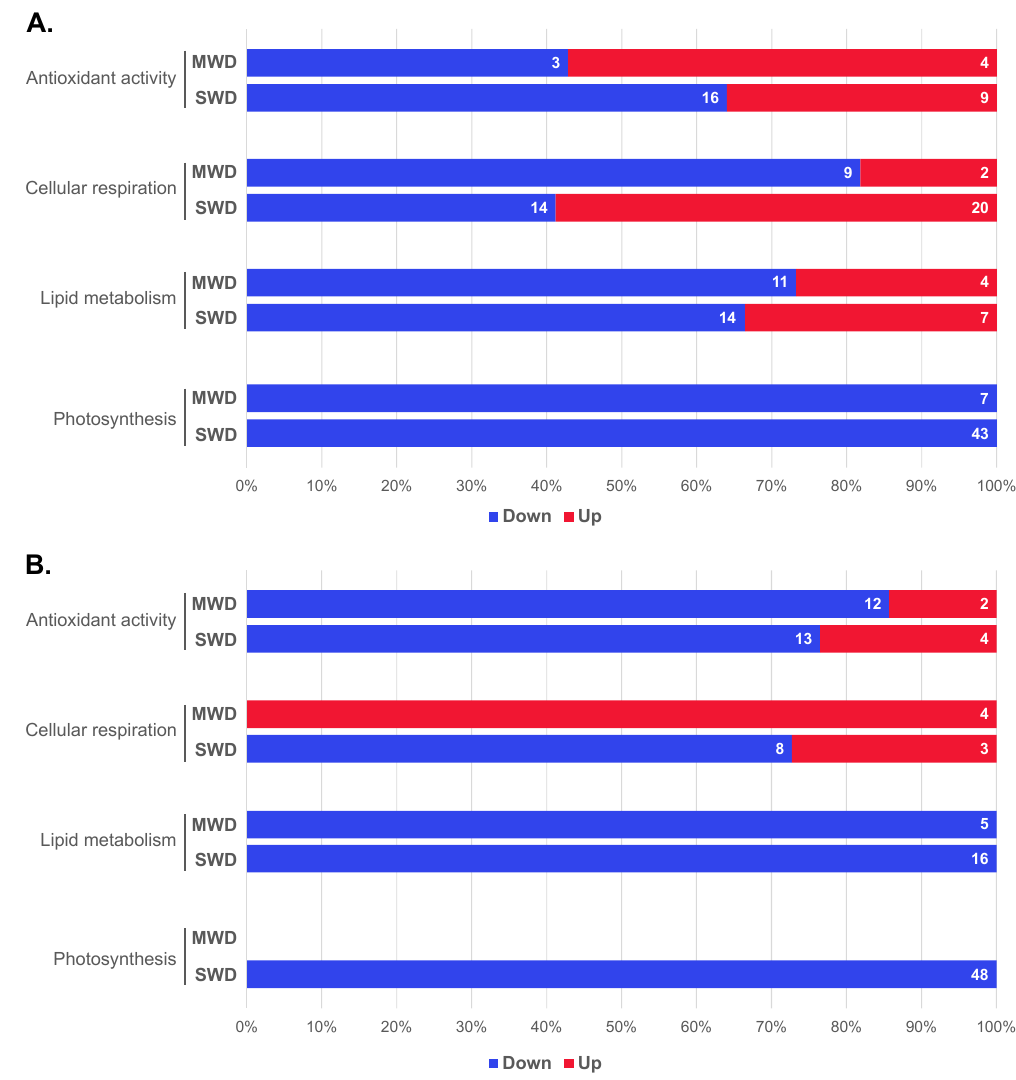
Figure 4. The proportion of significantly up-regulated (red) and down-regulated (blue) DEGs associated to physiological and biochemical responses in coffee that were found under moderate water deficit (MWD) and severe water deficit (SWD) relative to the well-watered (WW) control plants in ( A ) CL153 and ( B ) Icatu. DEGs represented in this plot were annotated with at least one of the following GO terms: “antioxidant activity” (GO:0016209), “response to oxidative stress” (GO:0006979) under Antioxidant activity; “cellular respiration” (GO:0045333), “mitochondrion” (GO:0005739), “malate dehydrogenase activity” (GO:0016615), “pyruvate kinase activity” (GO:0004743) under Cellular respiration; “fatty acid metabolic process” (GO:0006631), LOX (GO:0004051, GO:0016702) under Lipid metabolism; and “photosynthesis” (GO:0015979), “photosystem” (GO:0009521), “photosynthetic electron transport chain” (GO:0009767), “photorespiration” (GO:0009853), “chlorophyll biosynthetic process” (GO:0015995) under